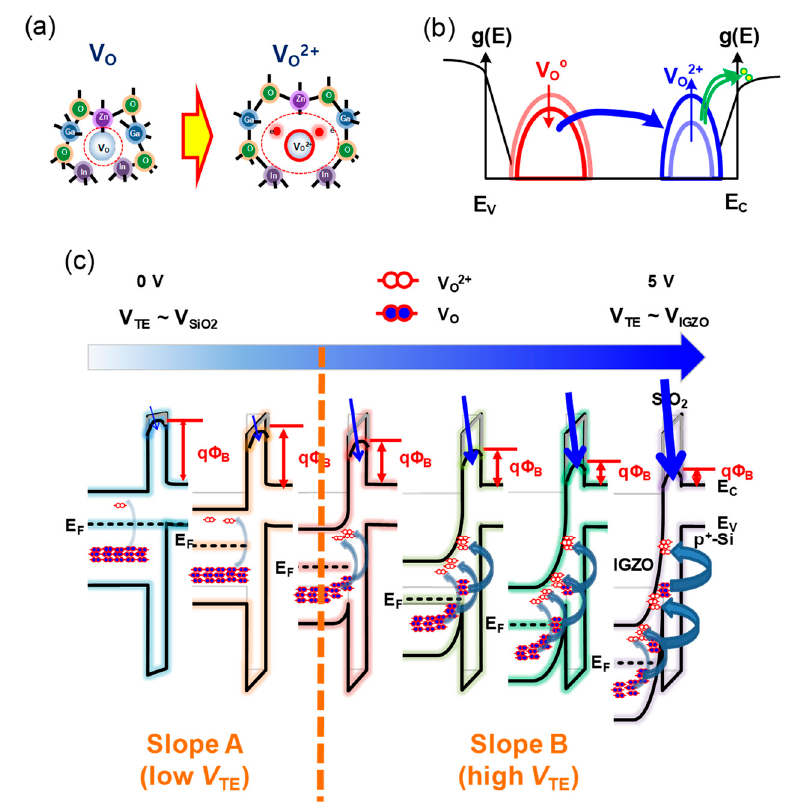
Figure 4. Schematic illustration of oxygen vacancies ionization from the viewpoint of ( a ) the atomic structures and ( b ) the subgap DOS in a-IGZO. ( c ) The read voltage V TE -dependent energy band diagram.